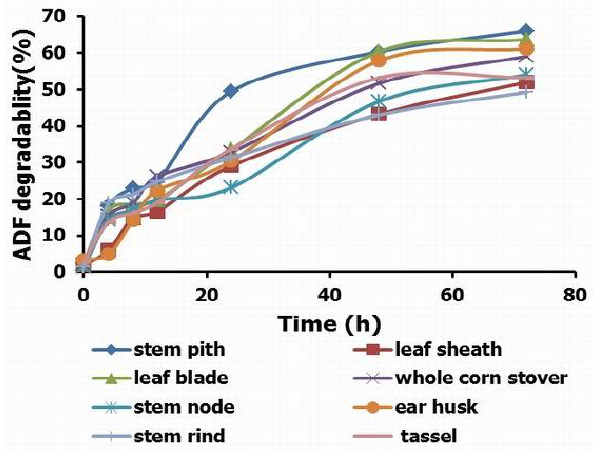
Figure 3. Acid detergent fiber degradability of whole corn stover and different morphological fractions during rumen incubation for different periods in dry